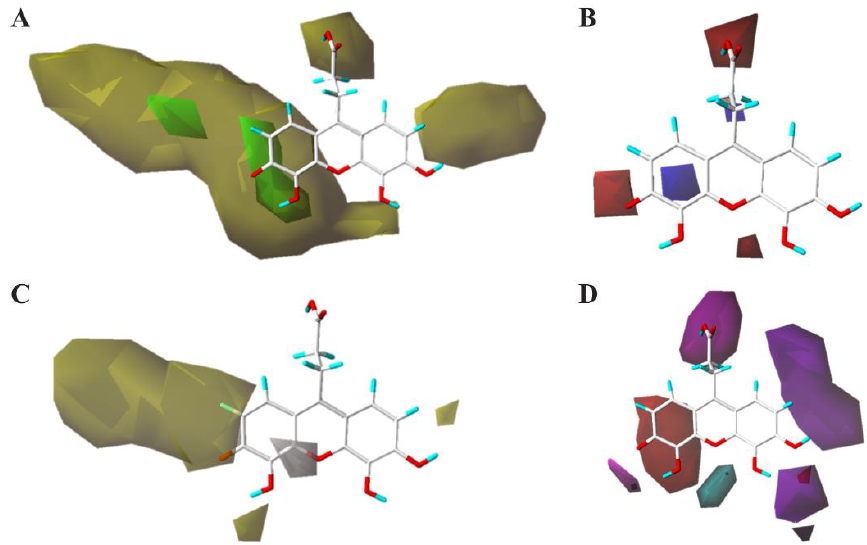
Figure 6. The contour maps of 3D-QSAR model show: ( A ) the steric bulk favored (green) and steric bulk disfavored (yellow) regions; ( B ) positive charge desirable (blue) and negative charge desirable (red) regions; ( C ) hydrophobicity desirable (yellow) and hydrophobicity undesirable (white) regions; ( D ) hydrogen bond donor desirable (cyan), hydrogen bond donor undesirable (purple), hydrogen bond acceptor desirable (magenta), and hydrogen bond acceptor undesirable (red) regions.